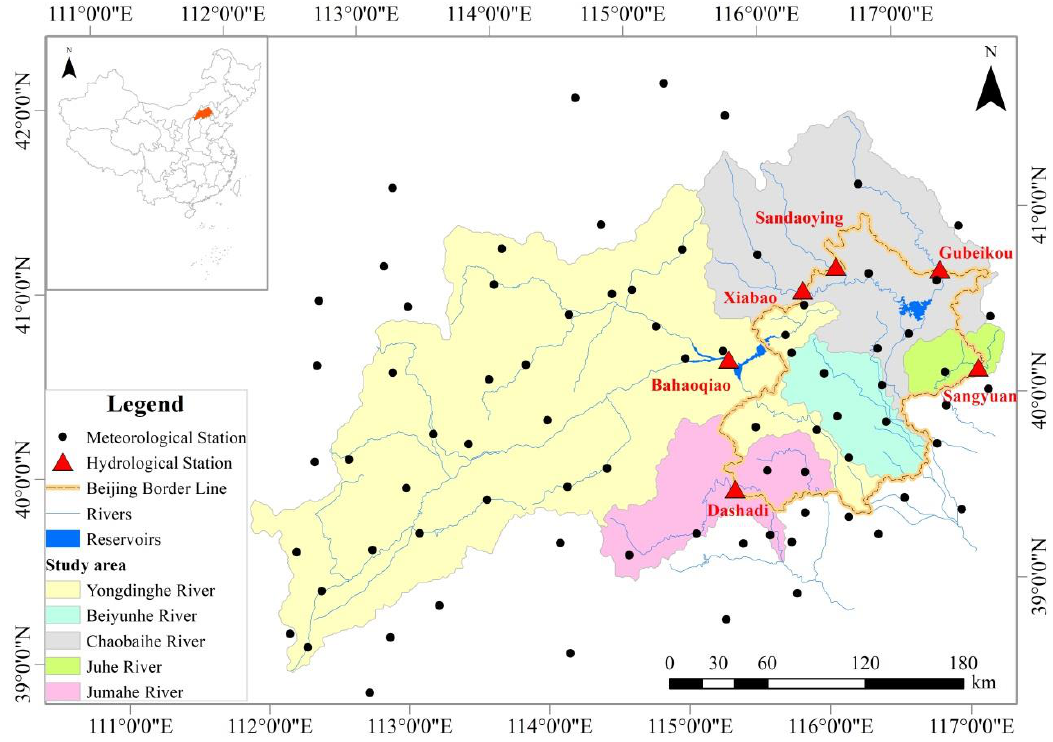
Figure 1. Locations of the catchments and hydro-meteorological stations.